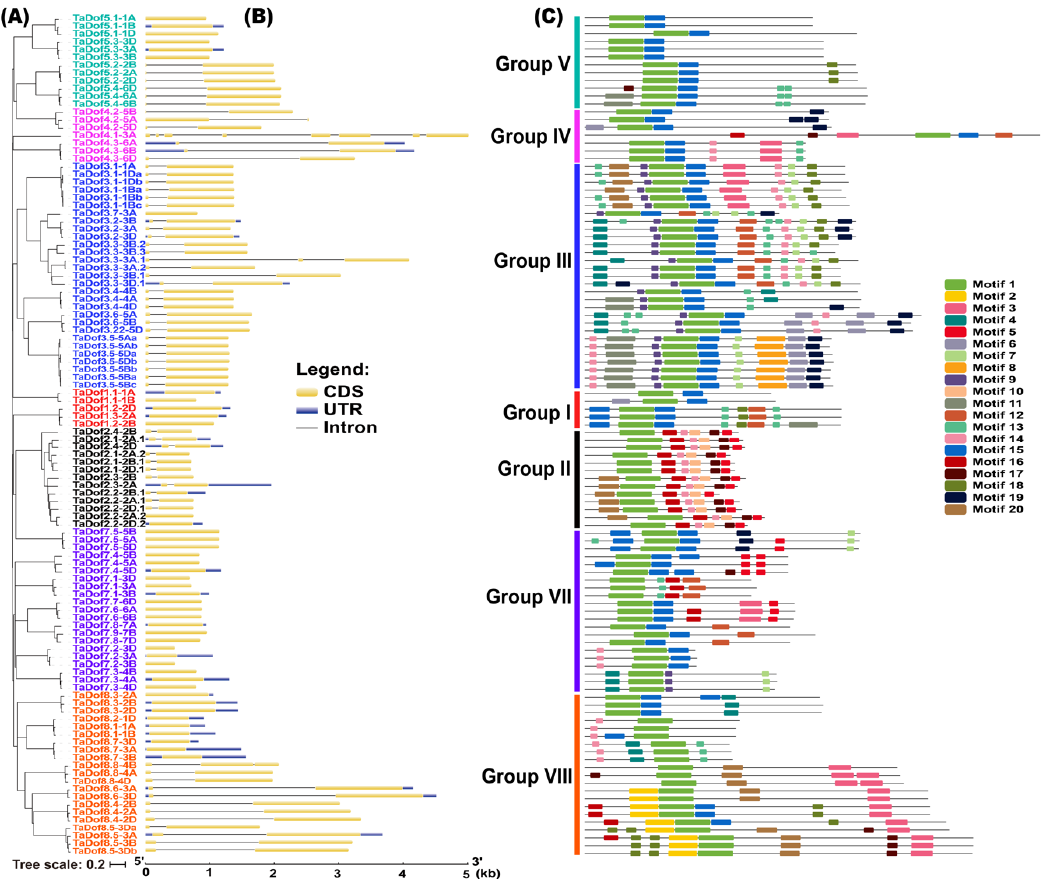
Figure 3. Phylogenetic relationships, exon–intron structures and motif compositions of wheat Dof (TaDof) proteins. ( A ) Multiple alignment of Dof proteins in Triticum aestivum L. The tree was constructed using MEGA7 with a bootstrap of 1000 by the maximum likelihood (ML) method. ( B ) Exon–intron structures of Dof genes in Triticum aestivum L. obtained from the GSDS database. Lengths of exons and introns for each TaDof gene are displayed proportionally. Untranslated regions (UTRs), exons and introns are represented by blue, yellow and black boxes / lines, respectively. ( C ) MEME analysis of TaDofs protein motif compositions. MAST was used to show the models of motif compositions in Dof amino acid sequences. Each box with a specific color indicates a motif and black lines represent non-conserved sequences.